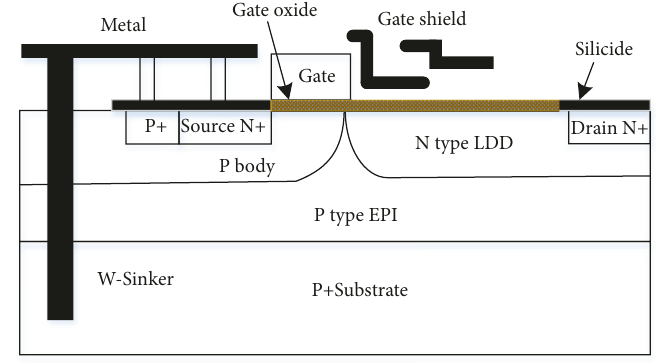
Figure 1: Structure of RF LDMOS.